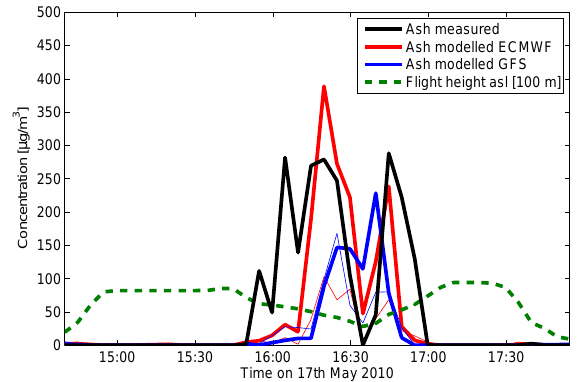
Fig. 9. Same as Fig. 8, but for a research flight over the North Sea on 17 May 2010.